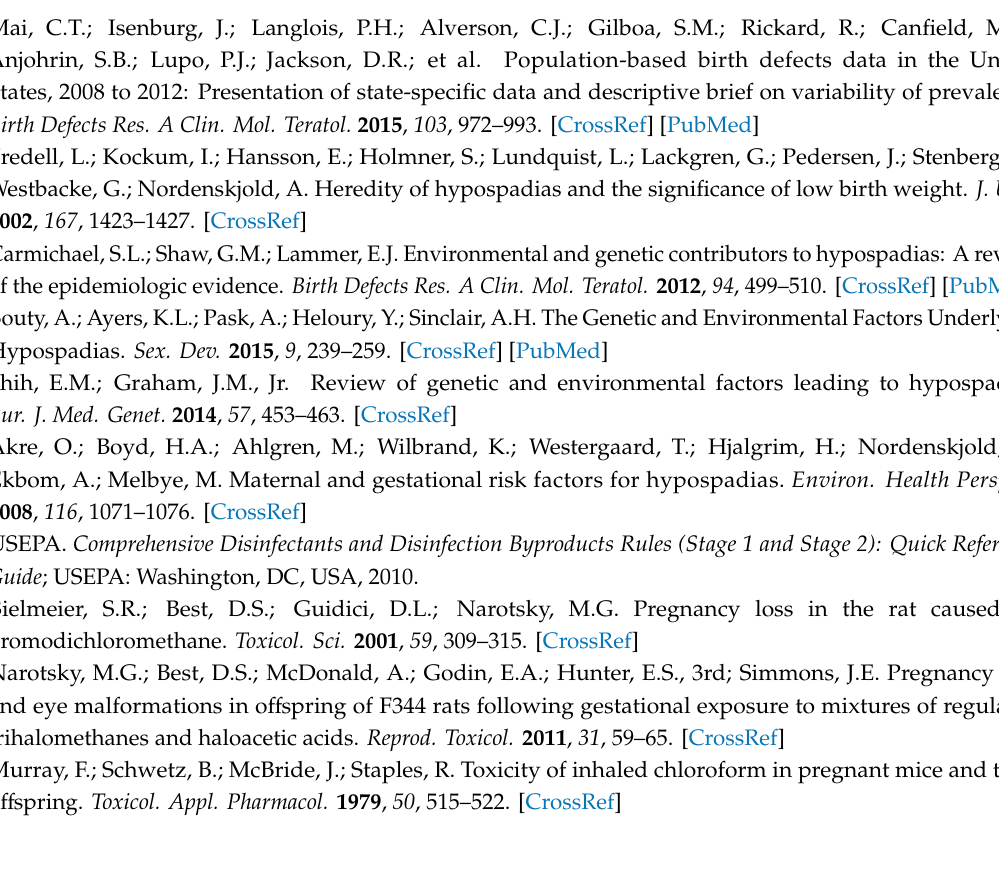
Table S1 . Comparison of maternal characteristics between primary analytic sample and well water drinkers, NBDPS (2000–2005); Table S2. Comparison of maternal characteristics between primary analytic sample and individuals excluded for missing DBP measurements, National Birth Defects Prevention Study (2000–2005); Table S3. Association between household DBP concentrations and hypospadias restricted to mothers with complete water-use data, National Birth Defects Prevention Study 2000–2005 ( n = 1213); Table S4. Association between household disinfection by-product (DBP) concentrations above and below US Environmental Protection Agency (EPA) allowable levels and hypospadias restricted to mothers with complete water-use data, National Birth Defects Prevention Study 2000–2005 ( n =